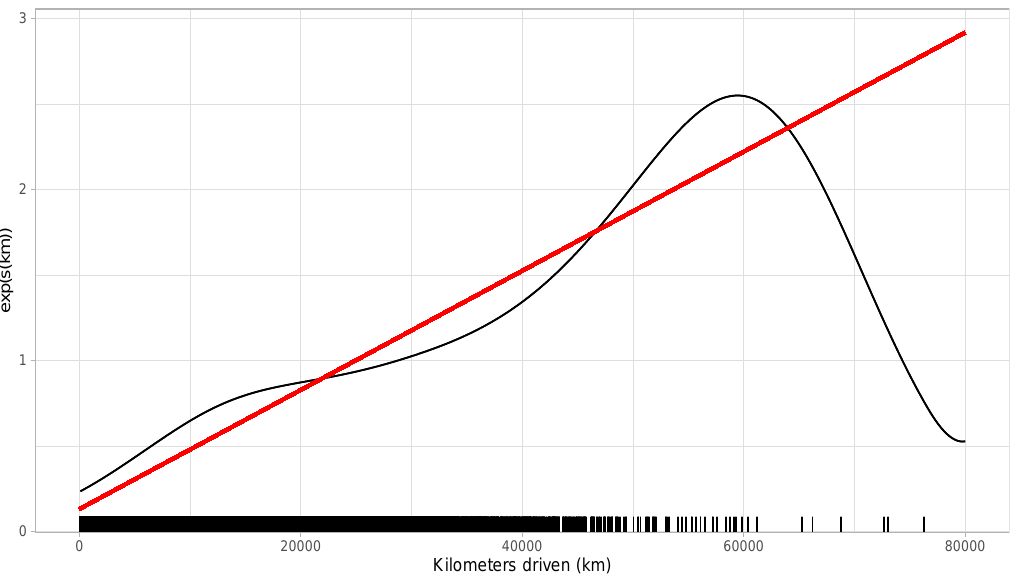
Figure 14. Comparison between the random effect approach and the fixed-effect approach for the median value of the individual